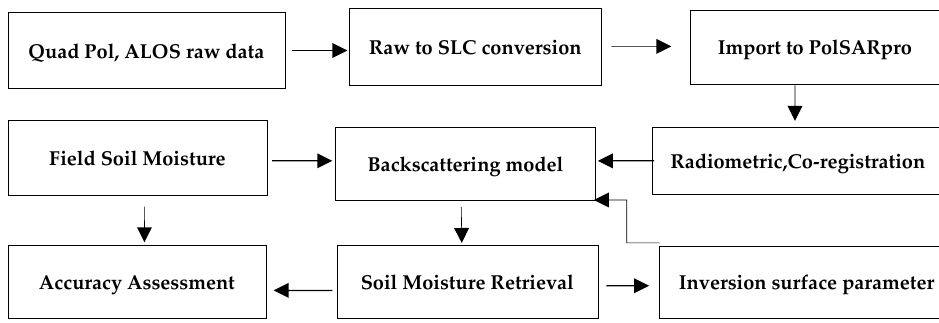
Figure 4. Process chain for quad polarization ALOS PALSAR